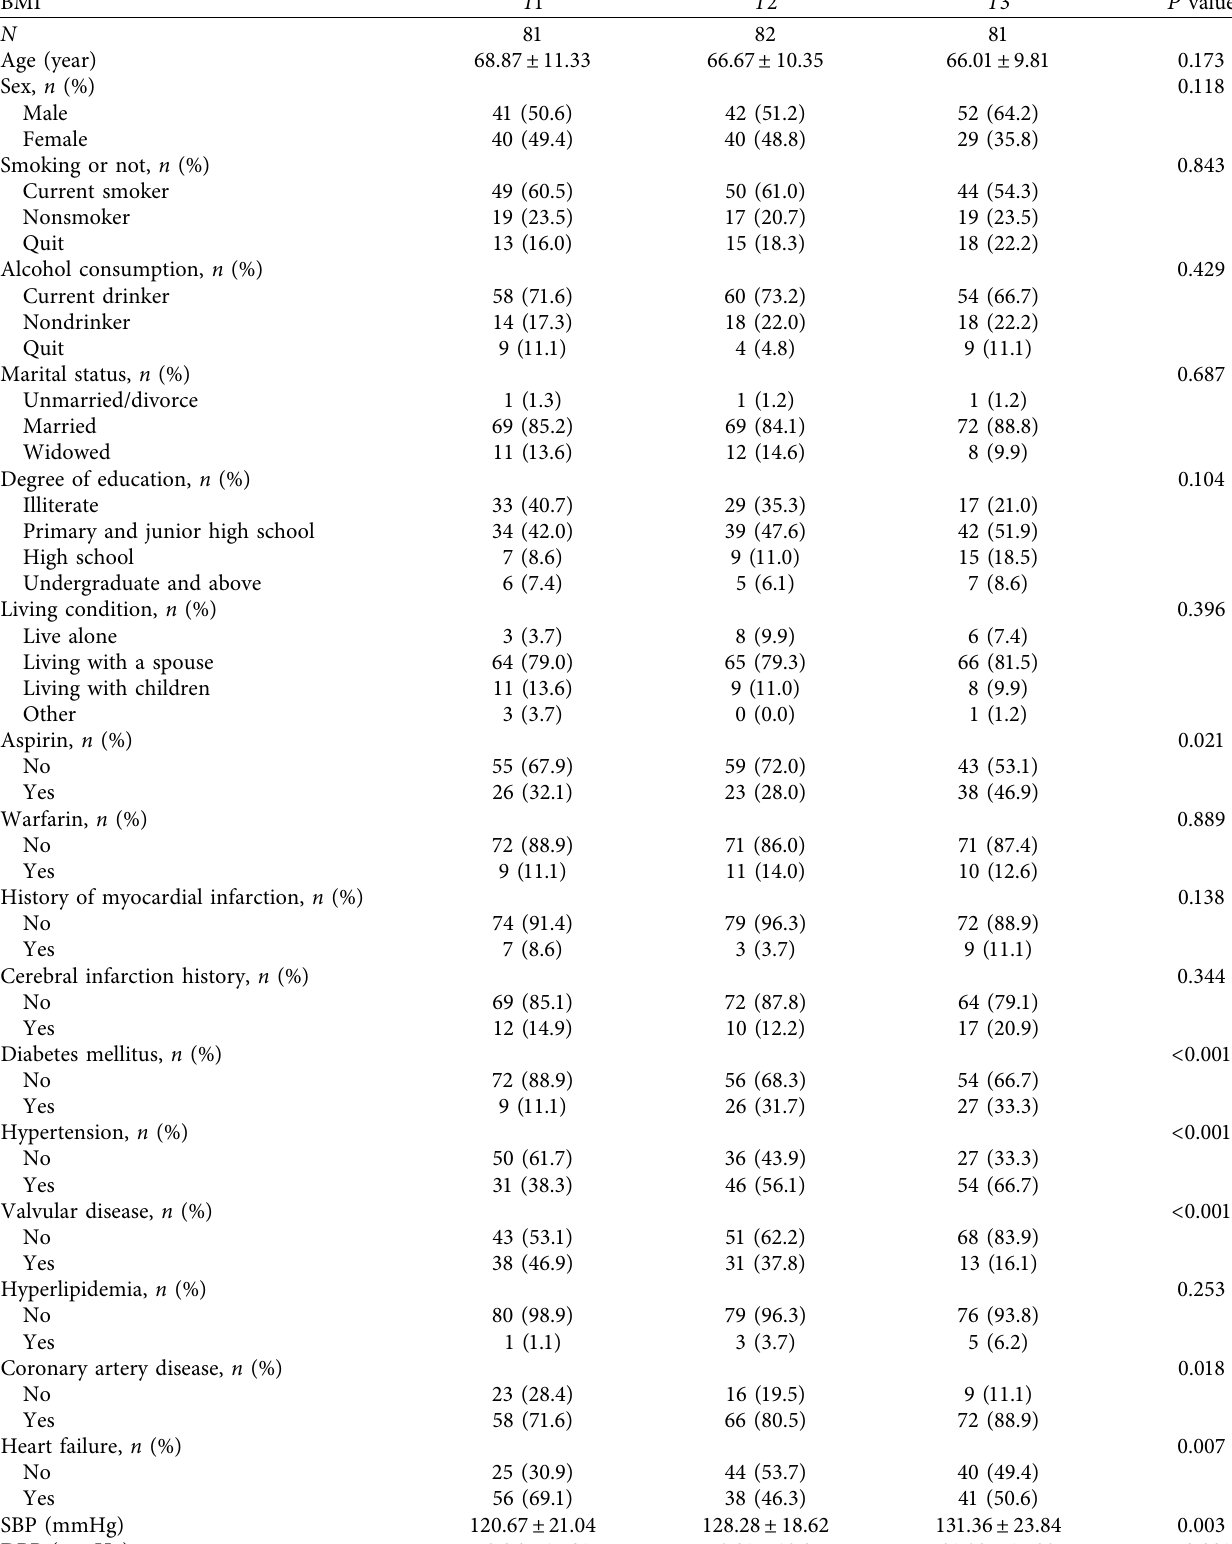
Table 1: Baseline characteristics of